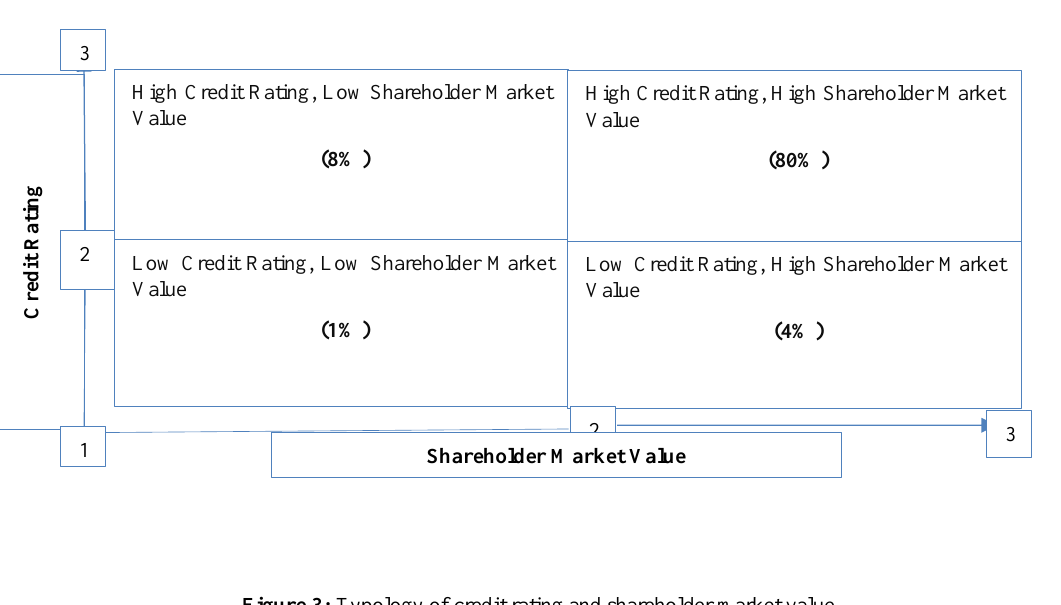
Figure 3: Typology of credit rating and shareholder market